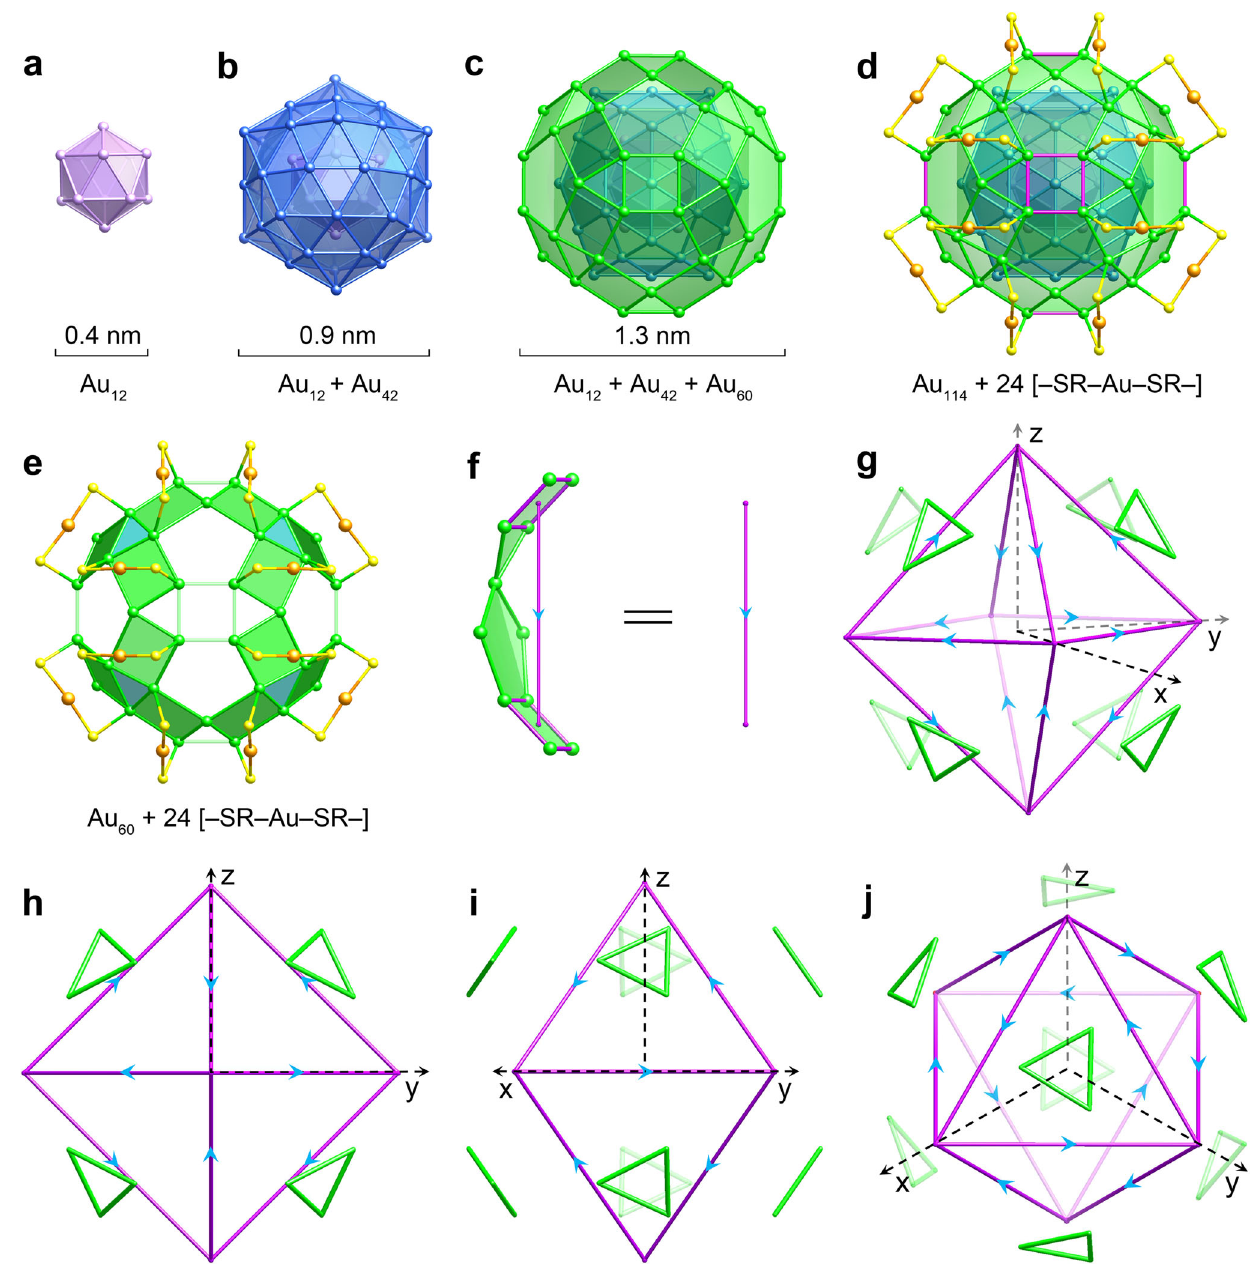
Fig. 1 | X-ray crystallographic structure anatomy and symmetry analysis of Au 138 (SR) 48 . a Innermost icosahedral Au 12 shell. b Second icosahedral Au 42 shell. c Third rhombicosidodecahedron-like Au 60 shell. d Total structure containing an Au 114 kerneland24[ – SR – Au – SR – ]staples.Rectanglesarehighlightedinmagenta. e 24 quadrangles belonging to eight subunits produce eight equilateral triangles(markedinblue)inthe thirdshell. f Substructureofthe Au 60 shellwitha